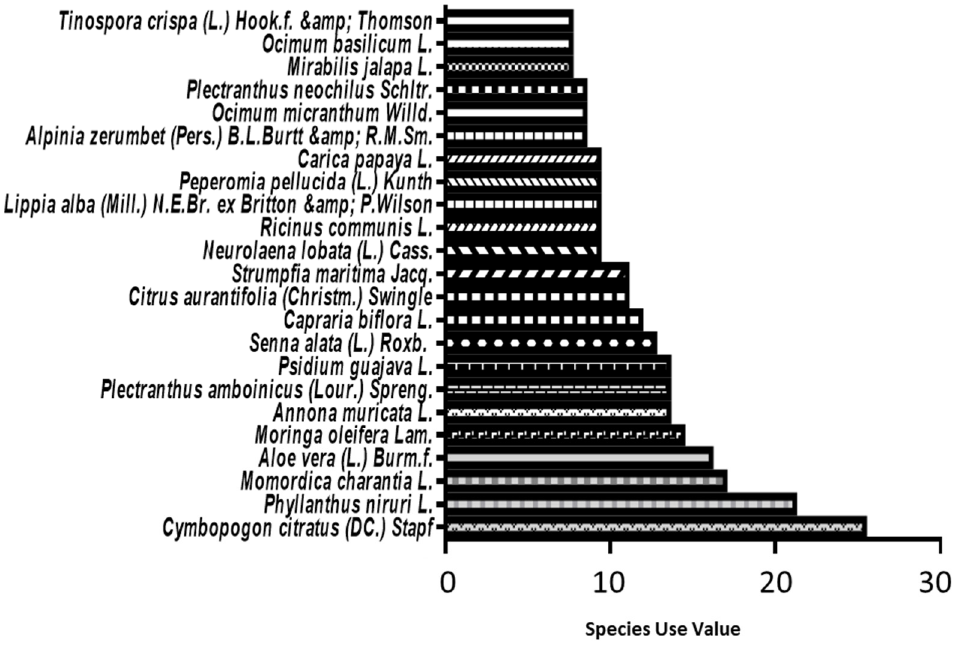
Figure 3. Medicinal use value of plant species commonly used in traditional folk medicine in Grand-Terre.